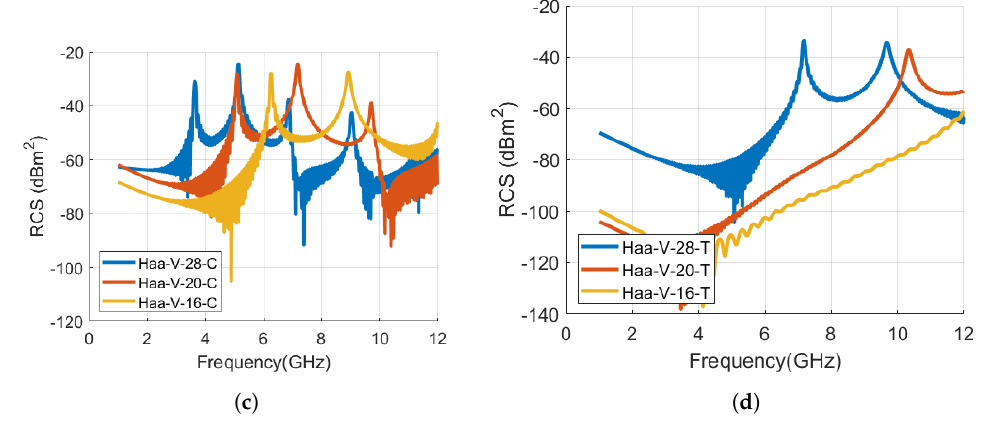
Figure 19. Designed letter and comparison of RCS results of alphabet Ł tag for vertical polarization with various font types and sizes: (a ) Designed letter Ł tag with various fonts and sizes; ( b ) Arial font with 28, 20 and 16 sizes; ( c ) Calibri font with 28, 20 and 16 sizes; and ( d ) Times New Roman (TNR) font with 28, 20 and 16 sizes. Table 9. Signature resonance frequencies for letter tag Ł with various font types and sizes (* represents resonant frequency out of analyzed frequency range).